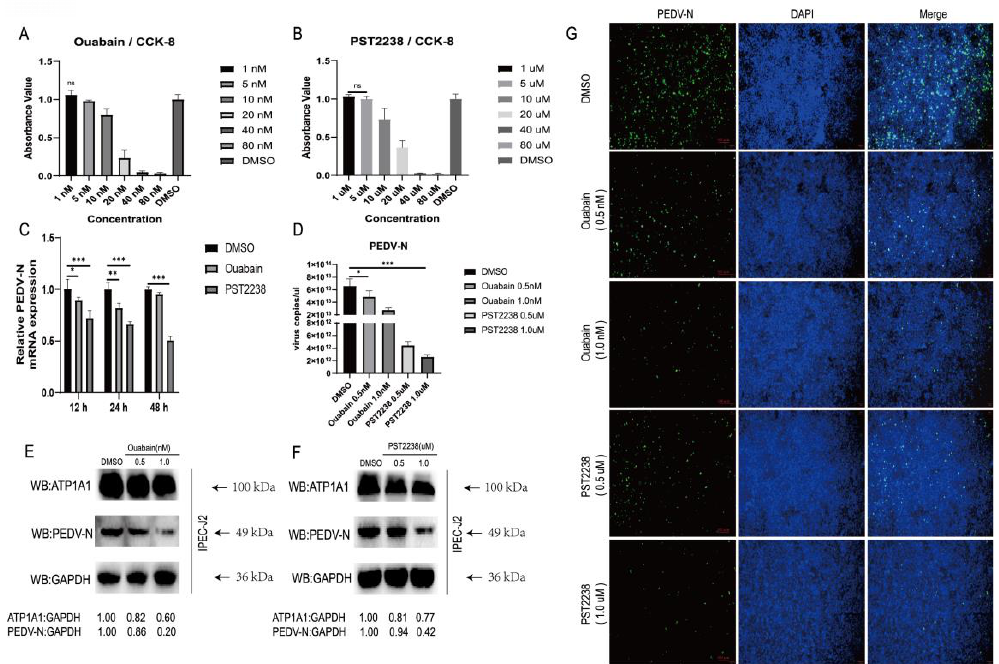
Figure 4. NKA inhibitors promote internalization and degradation of ATP1A1 and effectively reduce PEDV infection. ( A , B ) The cytotoxicity of Ouabain and PST2238. IPEC-J2 cells were treated with 1.0, 5.0, 10.0, 20.0, 40.0, 80.0 nM Ouabain and 1.0, 5.0, 10.0, 20.0, 40.0, 80.0 μM PST2238 for 48 h; DMSO was used as control. The treated cells were then analyzed using the CCK-8 kit. Data represent means ± SD from three independent experiments. *, p < 0.05; **, p < 0.01; ***, p < 0.001; ****, p < 0.0001; ns, no significant difference. ( C ) Treatment with Ouabain or PST2238 downregulates PEDV RNA abundance. IPEC-J2 cells were grown to 90% confluency, and 1.0 nM Ouabain or 1.0 μM PST2238 viral medium (0.1 MOI) was used to infect the cells for 1 h. After washing the cells with PBS, the maintenance solution containing the above concentrations of drugs was added to continue the culture. Cells were collected at 12, 24 and 48 h for viral RNA quantification. Data represent means ± SD from three independent experiments. *, p < 0.05; **, p < 0.01; ***, p < 0.001; ****, p < 0.0001; ns, no significant difference. ( D ) Treatment with Ouabain or PST2238 suppresses PEDV RNA abundance in a dose-dependent manner. Virus cultures containing 0.5, 1.0 nM Ouabain or 0.5, 1.0 μM PST2238 were infected with cells for 1 h. The virus-containing medium (0.1 MOI) was replaced with a growth medium containing the corresponding concentration of drugs for 24 h. Extraction of cellular RNA for quantitative PCR assay. ( E , F ) Treatment with Ouabain or PST2238 decreases PEDV N protein expression in a dose-dependent manner. Cells were treated in the same way as in Figure 7D and then cultured for 48 h. Cells lysates were prepared for Western blot analysis. ( G ) Treatment with Ouabain or PST2238 inhibits PEDV replication in a dose-dependent manner. Cells were treated in the same way as in Figure 7D and then cultured for 48 h. After fixation, penetration and closure of cells, staining with anti-PEDV-N mAb (green) and cell nuclei using DAPI (blue) staining solution. The processed samples were photographed and analyzed using fluorescence microscopy. Scale bars, 100 μm.